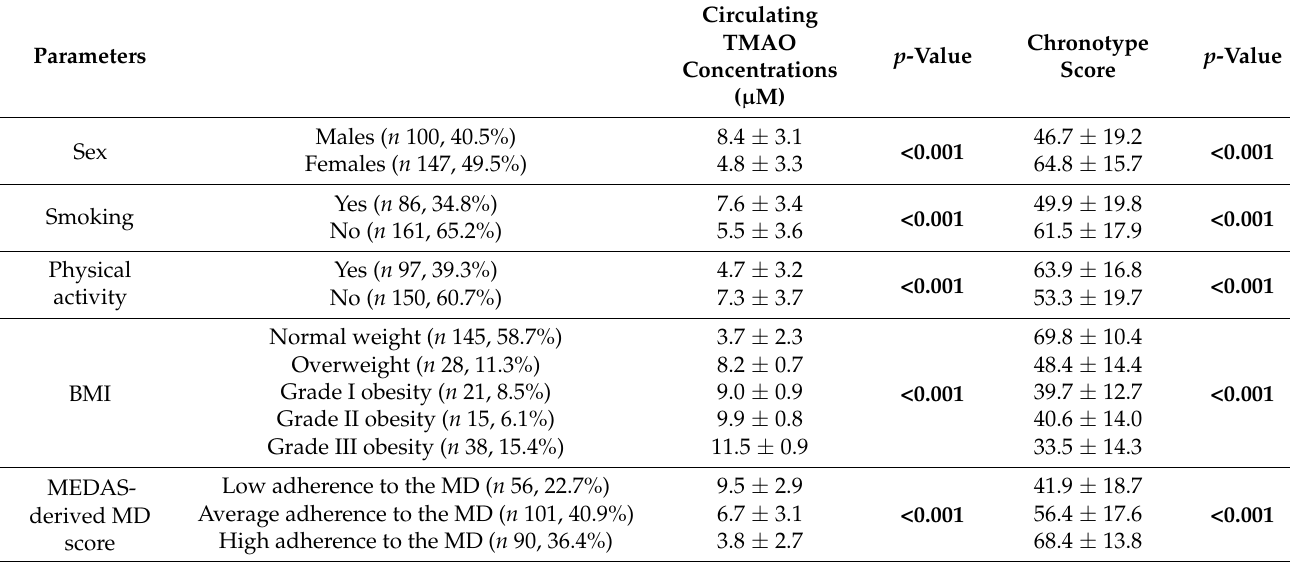
Table 2. Circulating TMAO concentrations and chronotype score in the study population according to sex, lifestyle habits, and BMI/MEDAS